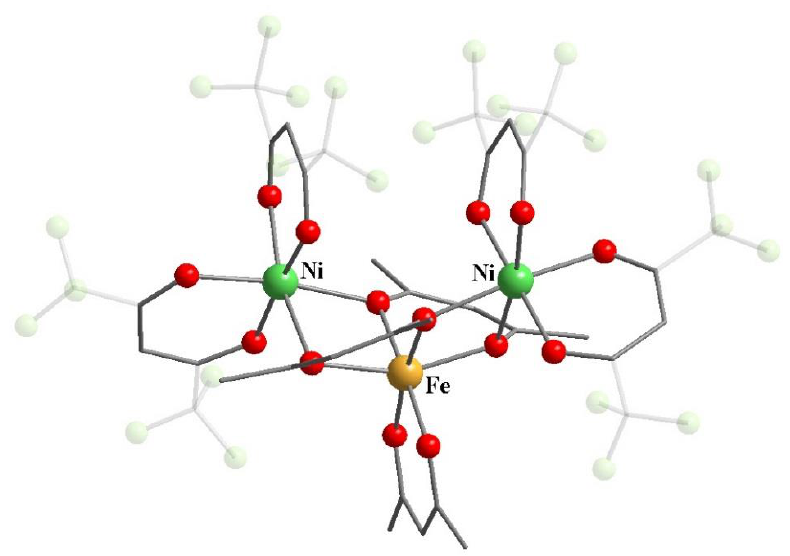
Figure 9. Molecular structure of 19 [69]. Hydrogen atoms have been omitted, CF 3 groups of hfac are transparent for clarity. The cif has been retrieved from CCDC. CCDC number is 1040553. The solid-state reaction of precursors containing metals of different oxidation states led to heteroleptic [Bi(III)-M(II)] ( 20 – 22 ) complexes, where M(II) was a 3d transition metal ion (Scheme 9) [70]. In this case, the bridging oxygen atoms between metal centers were from the hfac ligands of the anionic tris -diketonate fragment (Figure 10).